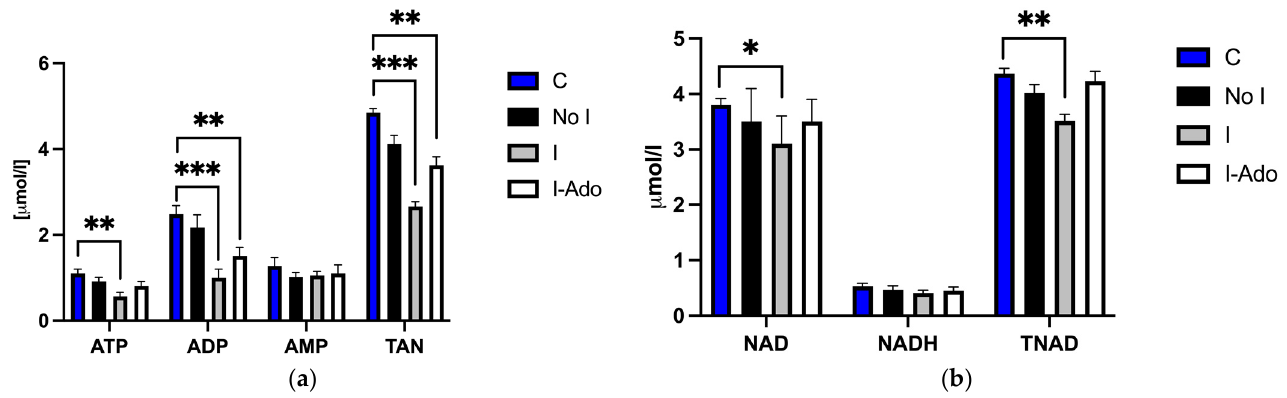
Figure 3. Mitochondrial ( a ) ATP, ADP, AMP, and TAN and ( b ) NAD, NADH, and TNAD before, during, and after 1 min ischemia in hearts subjected to 1 min ischemia at 40 min of perfusion, 10 min ischemia at 50 min of perfusion, and 1 min ischemia at 85 min of perfusion without (Group I) or with (Group I-Ado) supply of adenosine at 30 µM concentration during the fi rst 15 min of reper- fusion and in control hearts (Group No I) subjected three times to 1 min ischemia at 40, 50, and 85 min of perfusion. For the initial values, control hearts (Group C) were perfused for 20 min. Values are mean ± SEM ( n = 5–9). * p < 0.05, ** p < 0.01, *** p < 0.005. 2.4. Concentration of Free AMP Calculated Based on 31 P NMR (Nuclear Magnetic Resonance) Spectra The 31 P NMR spectra allowed the estimation of ATP, phosphocreatine inorganic phosphate concentrations, and pH value throughout the experiment. ATP levels remained constant during the 1 min ischemia at 40 and 85 min of the experiment, while they were lower in hearts subjected to 10 min ischemia in Group I. A transient infusion of adenosine during reperfusion after 10 min of ischemia partially restored ATP levels in Group I-Ado (Figure 4a). Phosphocreatine concentration decreased by 50% during 1 min ischemia at 40 min and was similar in all Groups. It was increased, however, before ischemia at 85 min in Groups I and I-Ado, but not in Group I. During 1 min ischemia at 85 min, phosphocre- atine concentrations in Groups I and I-Ado were slightly higher than in No I (Figure 4b). Intracellular inorganic phosphate increased two-fold during ischemia at 40 min in Group I, followed by a rapid decrease to below preischemic values at reperfusion. These changes were similar in all Groups. This pa tt ern of changes in inorganic phosphate concentration during 1 min ischemia were similar in all Groups at both time points (Figure 4c). The concentrations of ATP, phosphocreatine, and inorganic phosphate, and the pH value obtained from the 31 P NMR spectra, were used to calculate the free AMP concentra- tion. During 1 min ischemia at 40 min, the free AMP concentration (Figure 5a) increased to 8–11 µM. This increase was reduced to the same extent (4 and 5 µM, respectively) in Groups I and I-Ado during 1 min ischemia at 85 min, while it was maintained at 9 µM in Group No I. The pH decreased from a preischemic value of 7.04 to 6.90 during ischemia after 40 min of perfusion. This change was similar in all Groups. However, during 1 min ischemia at 85 min of perfusion, pH decreased only to 6.96 in the I and I-Ado Groups, while the magnitude of the pH decrease was maintained in Group No I (Figure 5b).